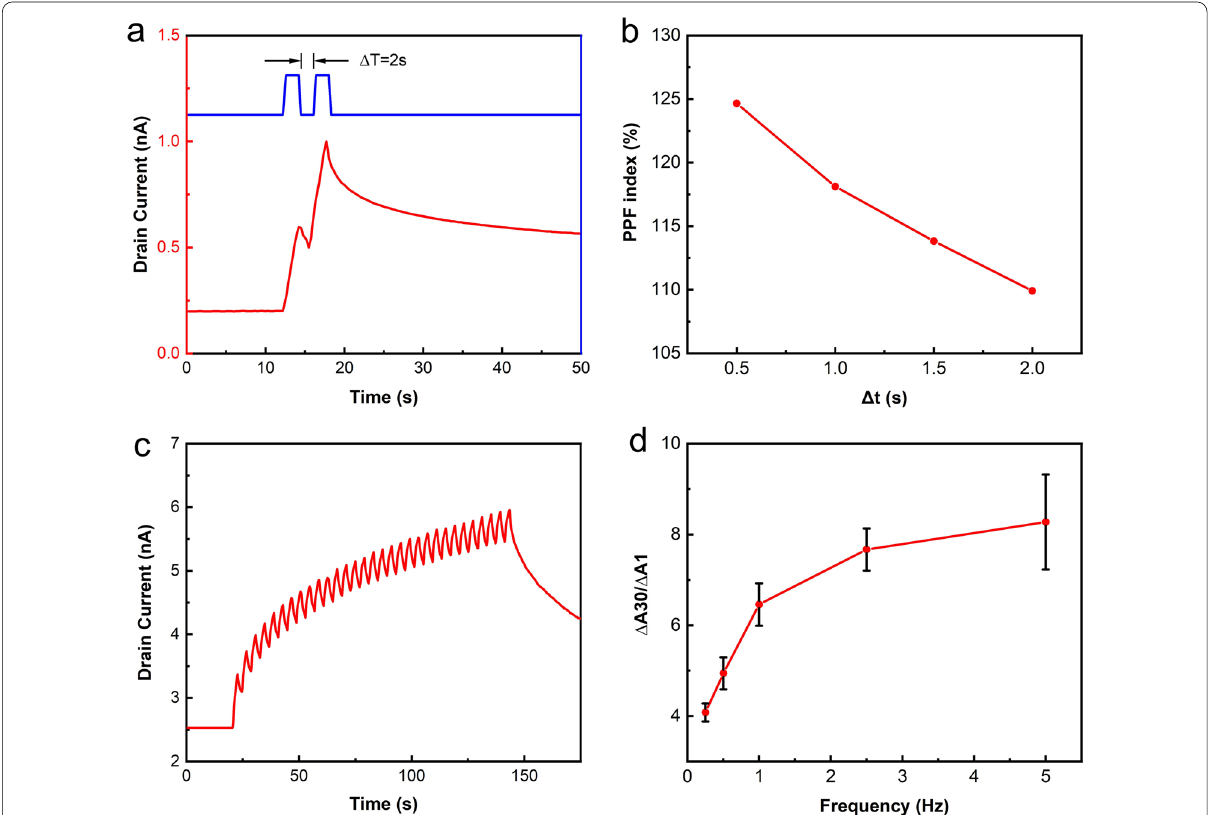
Fig. 4 a A typical PPF behavior of the CdSe QDs/IGZO hybrid channel synaptic phototransistor. b The PPF index as a function of the light pulse interval (532 nm, 1 mW/cm 2 ). c the LTP behavior of the phototransistor measured by applying 30 continuous light pulses (532 nm, 1 mW/cm 2 , 2 s). d The EPSC gain ratio (∆ A 30/∆ A 1) as a function of the light pulse